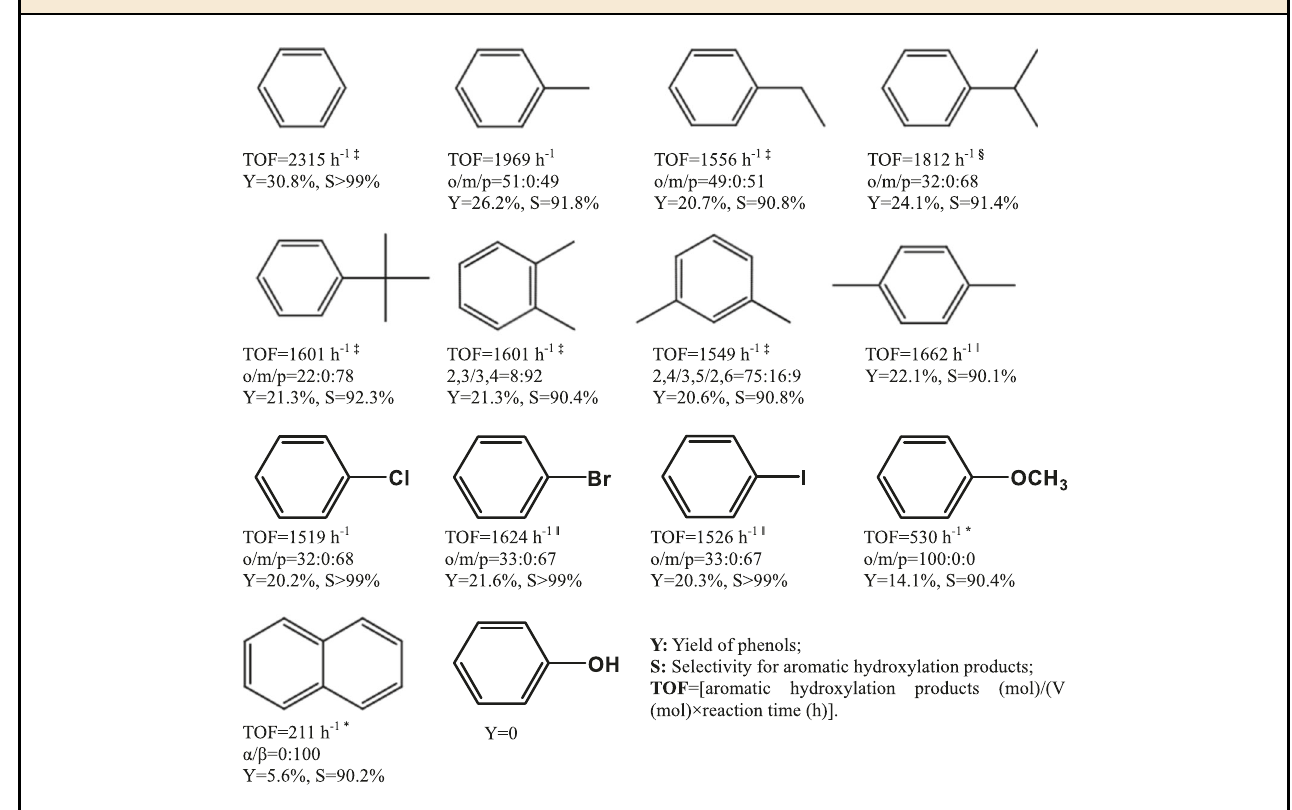
Table 1 Direct hydroxylation of various arene substrates with H 2 O 2 catalyzed by VSZ-5.